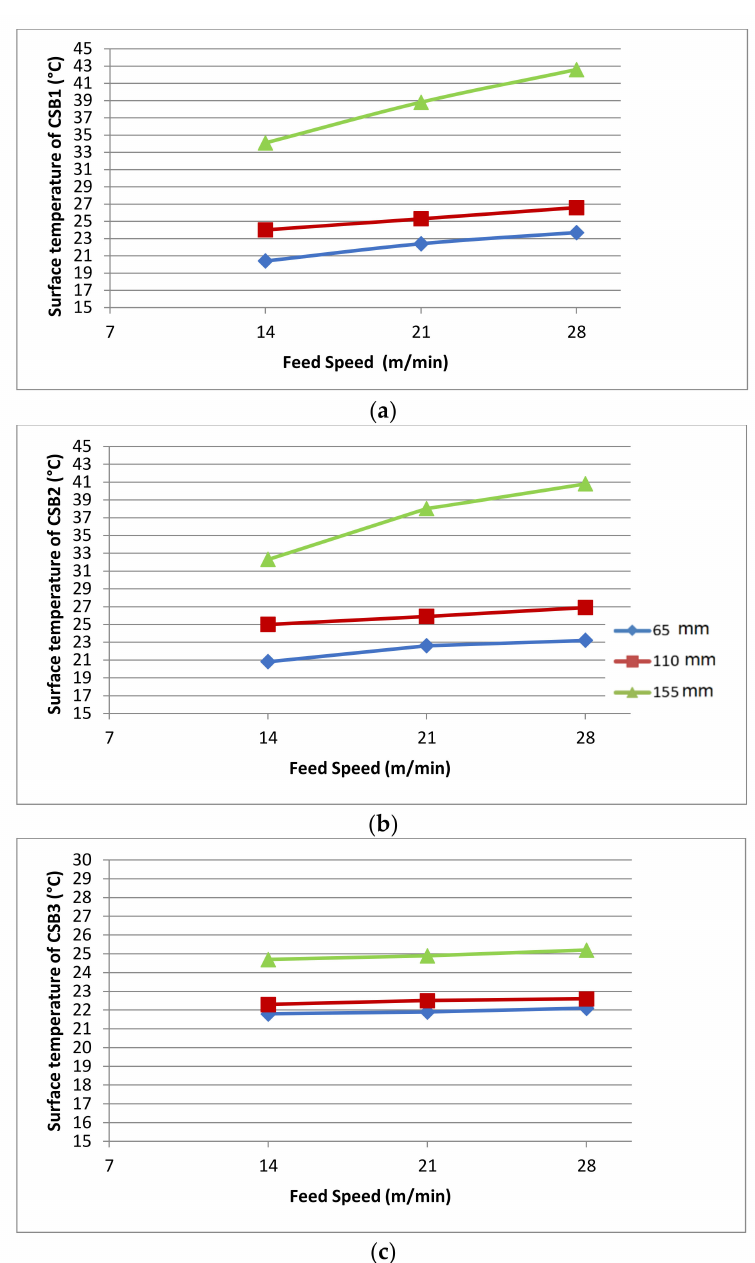
Figure 7. Dependence of the circular saw blade surface temperature on the feed speed at a shaft speed of 4050 rev/min: ( a ) CSB1, ( b ) CSB2, and ( c )